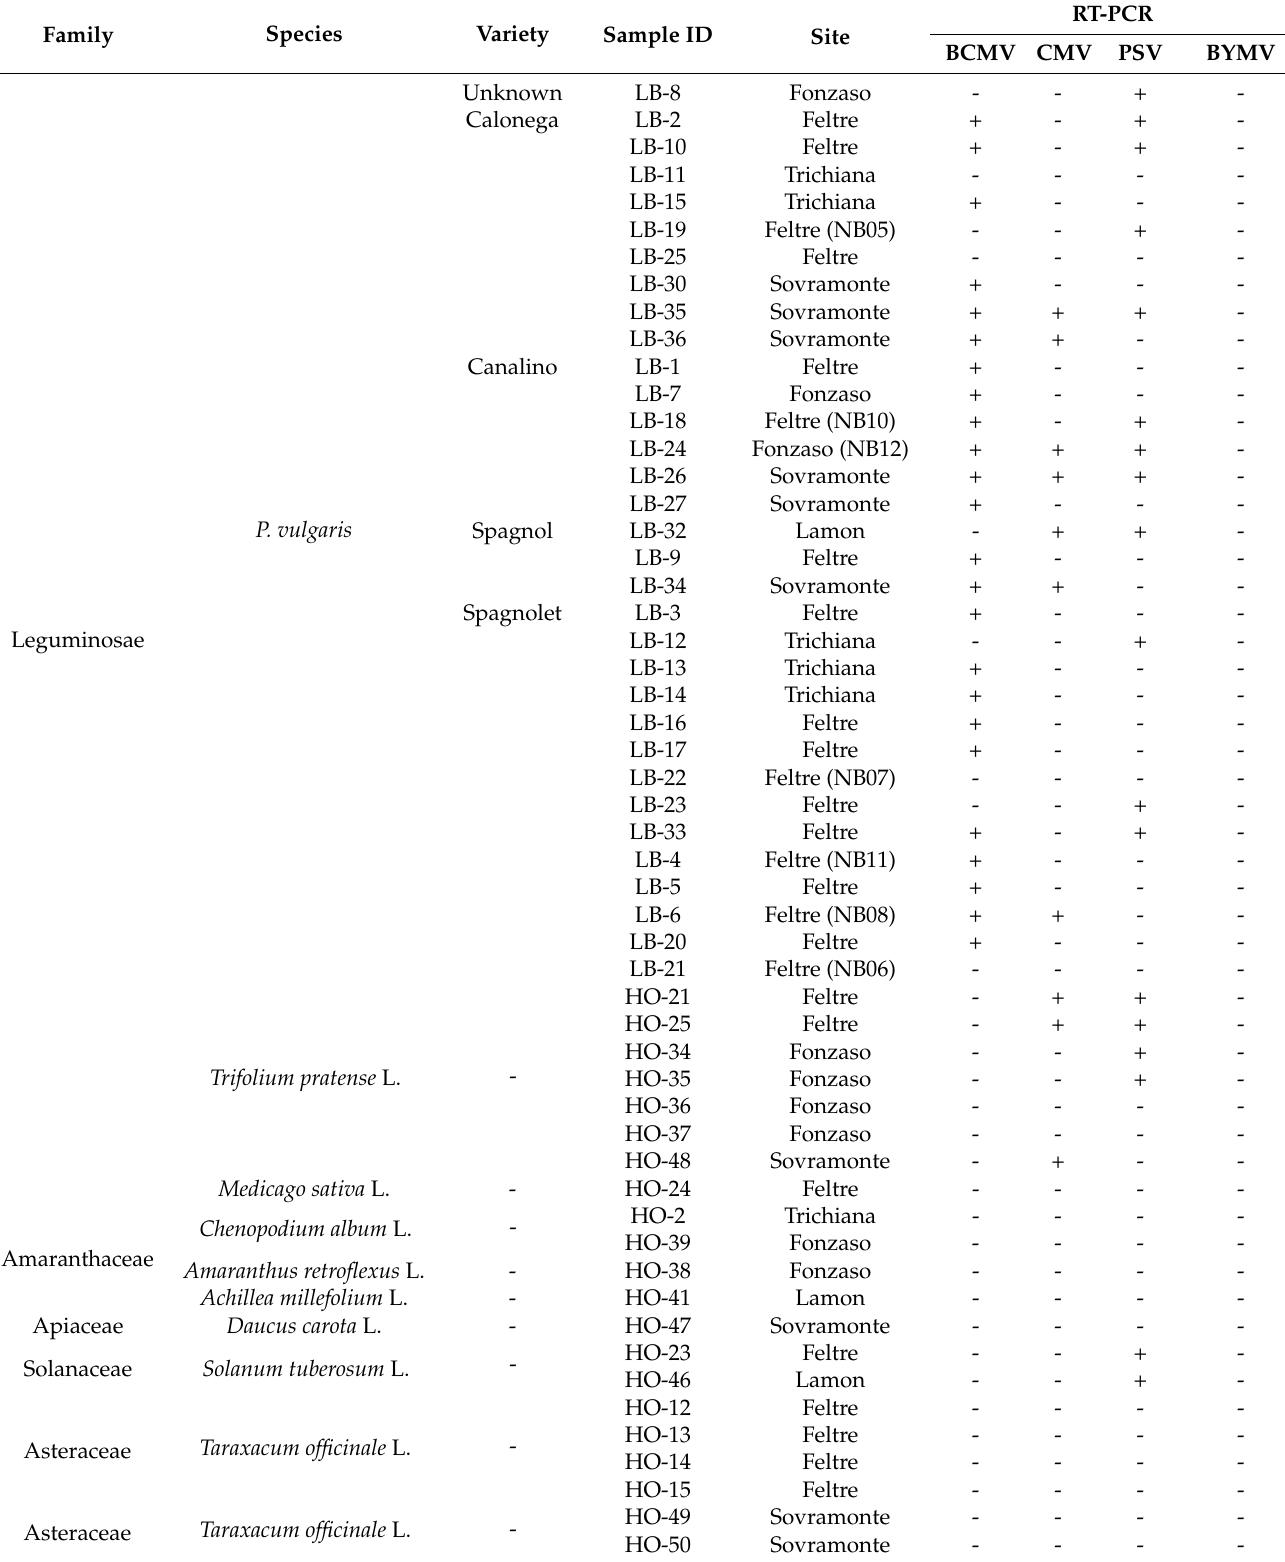
Table 1. Results of RT-PCR detection of viruses in Lamon bean and herbaceous hosts collected in different